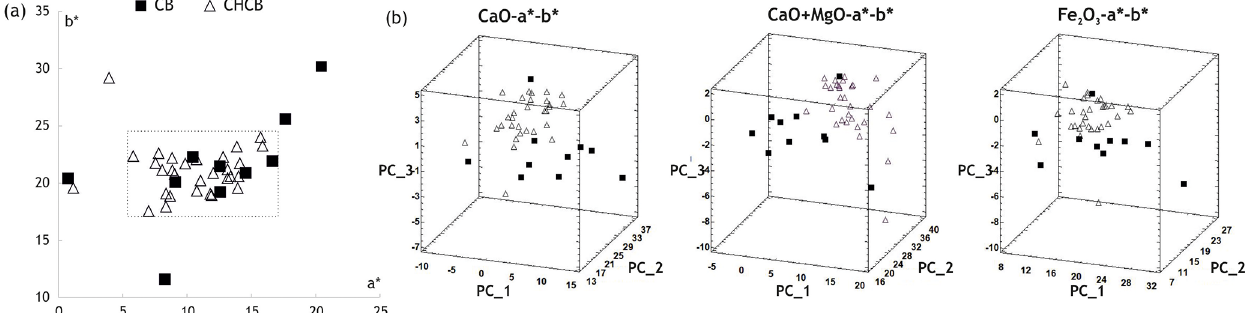
Figure 2. Chromatics of the CB and CHCB samples compared with their CaO, CaO + MgO and Fe 2 O 3 contents. (a) Plotting of the chro- matic coordinates a ∗ and b ∗ – many samples are closely grouped together within the rectangular area; (b) score plot of the principal component analysis (PCA). PC1, PC2 and PC3 were determined by taking into consideration the chromatic coordinates a ∗ and b ∗ and the CaO, CaO + MgO and Fe 2 O 3 content,